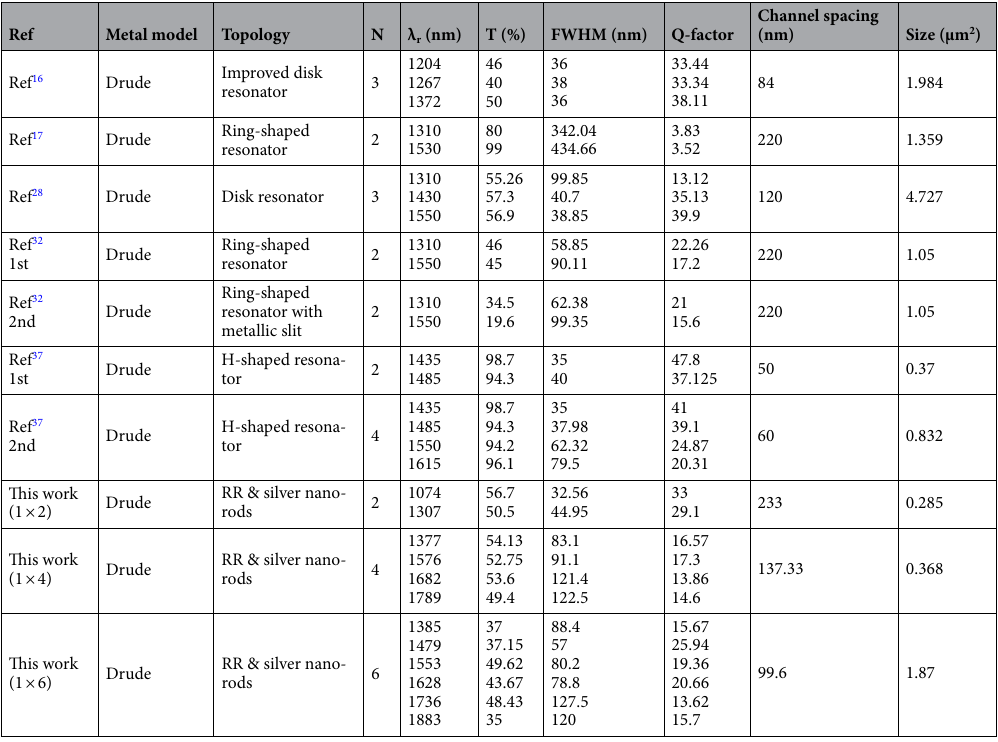
Table 1. Performance comparisons between the proposed DEMUXes and other